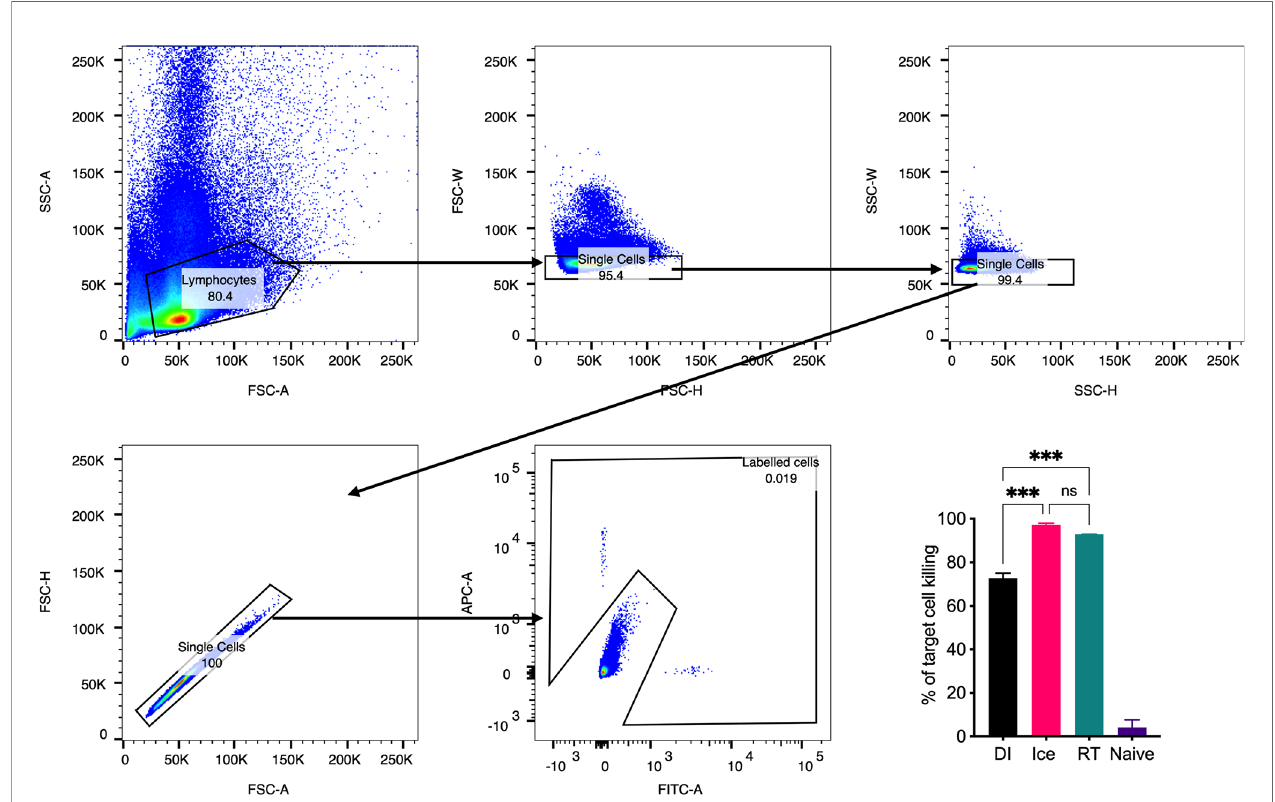
FIGURE 5 | CTL responses are induced by vaccination with g -Flu. Mice were vaccinated intravenously with g -Flu preparations (RT-, Ice-, and DI- g -Flu) or treated with PBS as mock control. 7 days later equal ratios of NPP-pulsed (CFSE labelled) and unpulsed (CTR labelled) splenocytes from naïve donor mice were injected into g -Flu vaccinated mice or mock-vaccinated controls. 24 hours later splenocytes were harvested, processed and analysed using fl ow cytometry. Gating strategy is shown. The change in ratio of pulsed to unpulsed splenocytes after injection into vaccinated animals was used to calculate the percentage killing of pulsed cells. Data presented here as mean percentage +/- SEM and analysed using one-way ANOVA (***p < 0.001, ns, not signi fi cant, n =